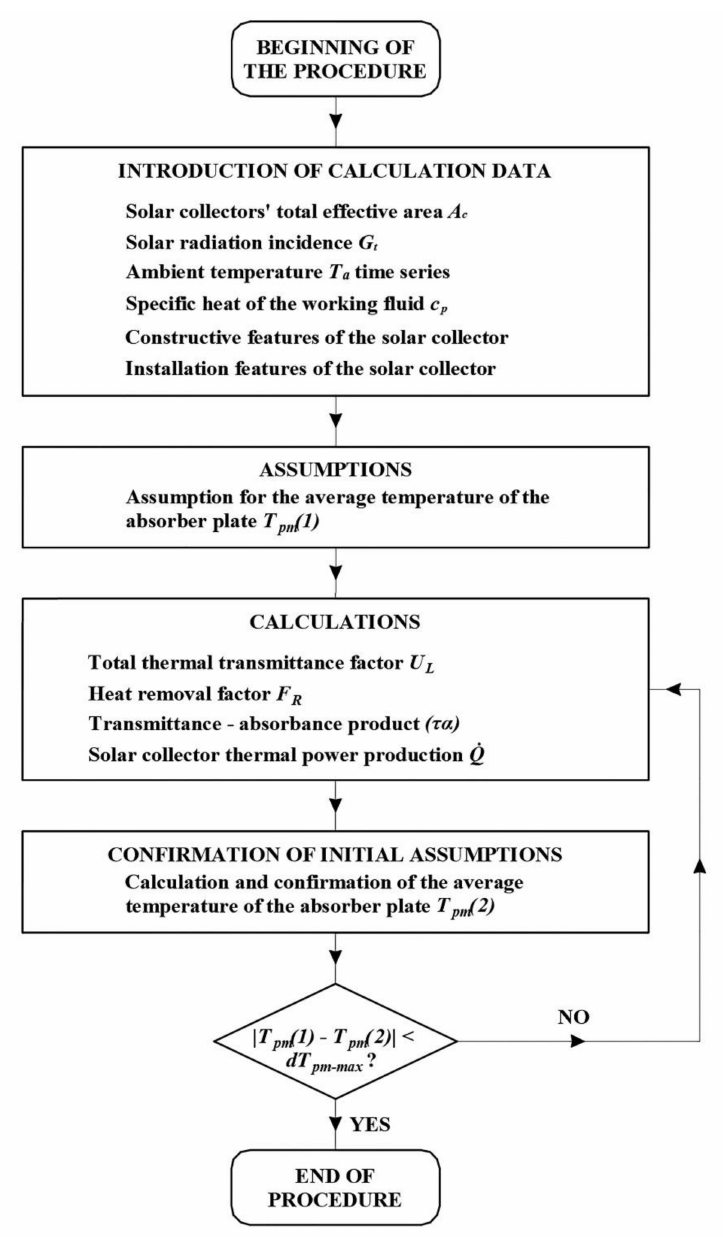
Figure 16. Flow diagram of the calculation procedure for the thermal power production from a flat-plate solar